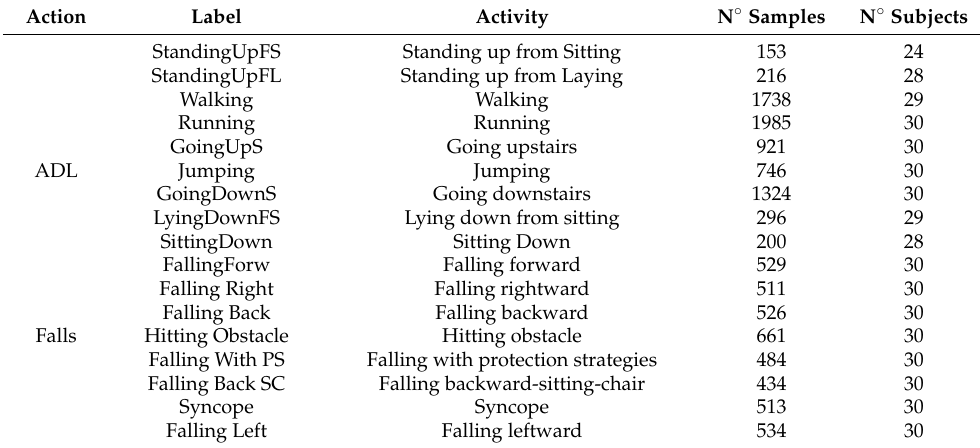
Table 3. UniMiB-SHAR dataset